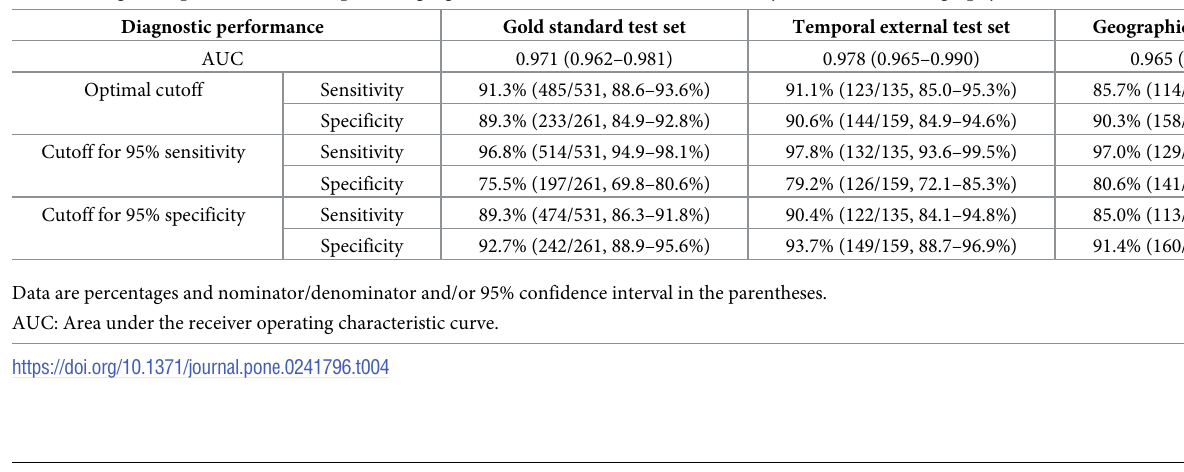
Table 4. Diagnostic performance of deep learning algorithm in all test sets based on labels by conventional radiography. Diagnostic performance